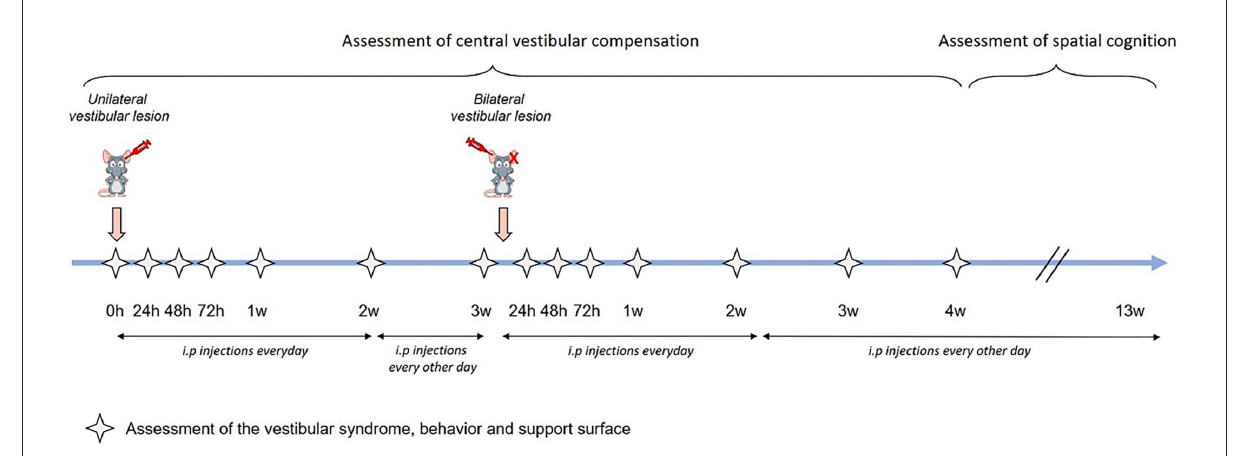
FIGURE1 Study timeline. Assessment of central vestibular compensation was made through the analysis of the vestibular syndrome, the behavior and support surface. Each analysis was carried out at several time points: before the transtympanic injection (referred as pre-op), 24h, 48h, 72h, 1 week, 2 weeks, and 3 weeks after unilateral transtympanic injection, and 24h, 48h, 72h, 1 week, 2 weeks, 3 weeks, and 4 weeks after sequential bilateral transtympanic injection. Assessment of spatial cognition started 4 weeks after sequential bilateral transtympanic injection.